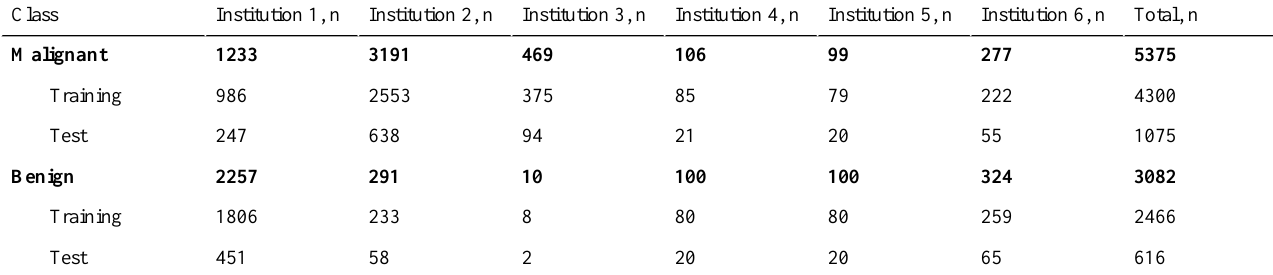
Table 1. Thyroid ultrasound image data from 6 medical institutions used to validate federated